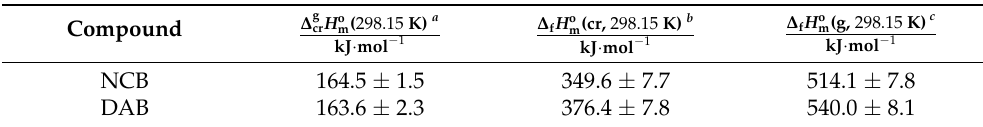
Table 6. Standard ( p ◦ = 0.1 MPa) molar enthalpies of sublimation and formation in gas-phase at T = 298.15 K for NCB and DAB, respectively.